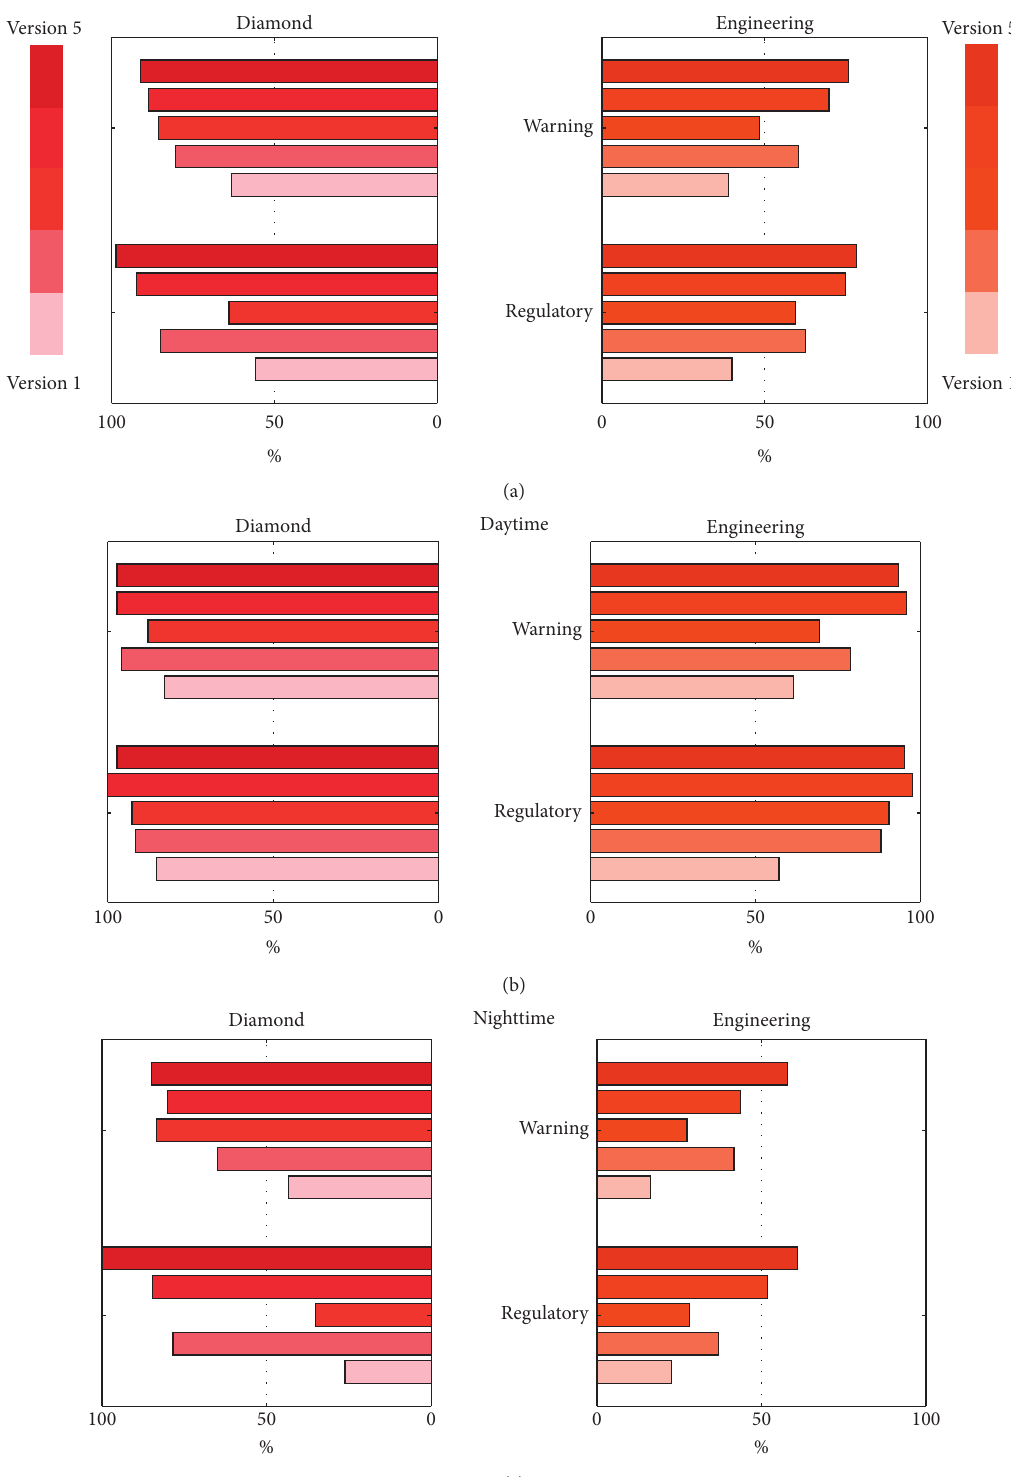
Figure 7: Recall parameter comparison between (a) sheeting types, (b) sheeting types with daytime lighting, and (c) sheeting types with night time